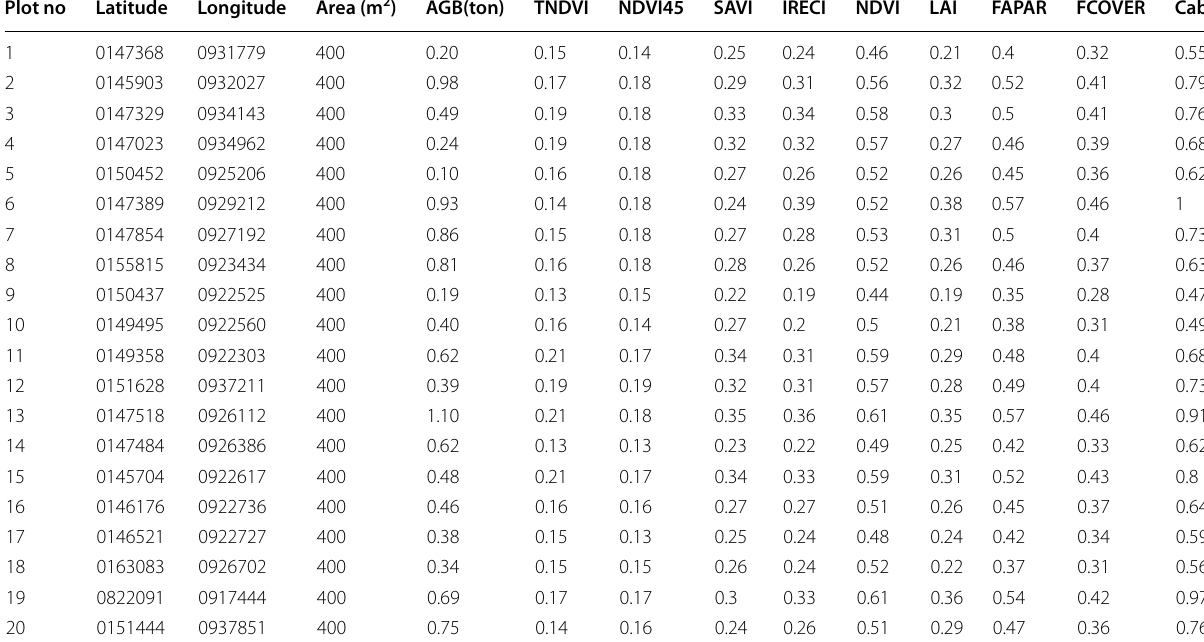
Table 4 Pixel values of vegetation indices extracted from Sentinel-2 image and AGB measured from plots Plot no Latitude